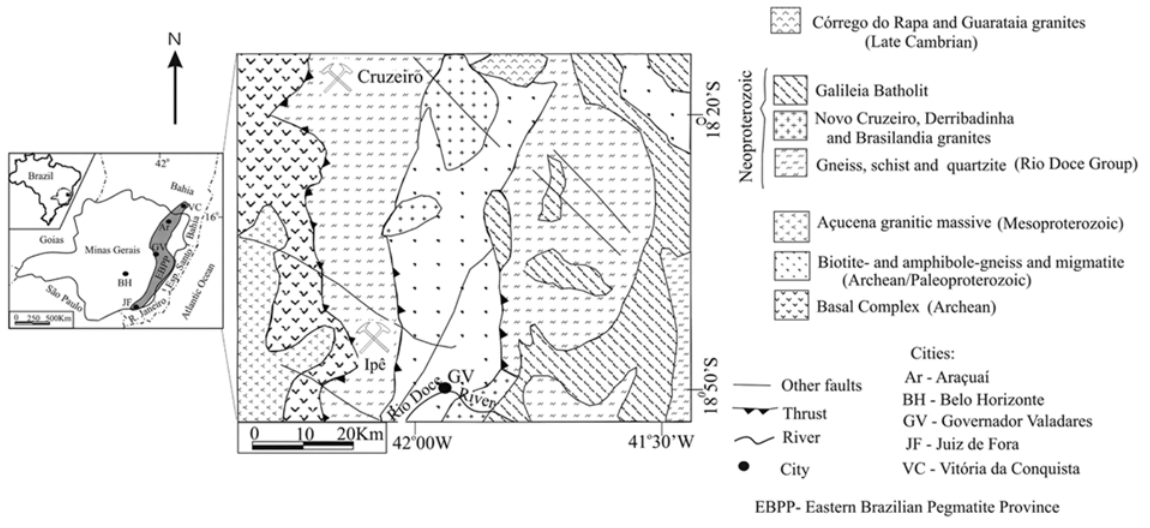
Fig. 1 – Simplified geological map of the Araçuaí and Governador Valadares regions with location of the Cruzeiro pegmatite. Outline of the Eastern Brazilian Pegmatite Province (EBPP) is also shown (modified after Oliveira et al. 1997 and Pedrosa-Soares and Wiedemann-Leonardos 2000).